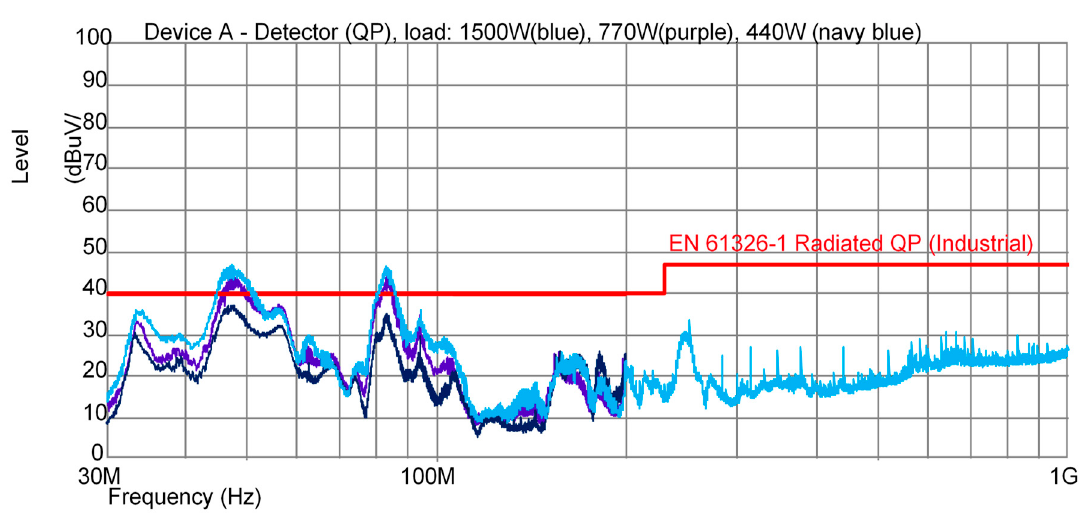
Figure 7. Frequency spectrum of radiated emission of PWM-based power source for frequency of generated voltage equal to 50 Hz and the values of the active load power equal to 1500, 770, and 440 W.